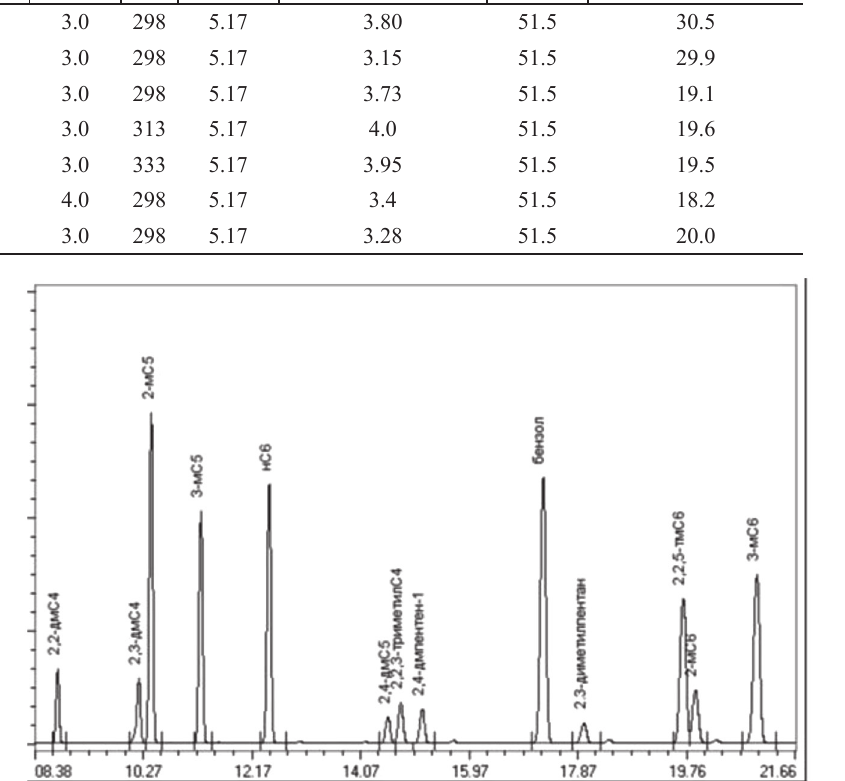
Table 3 – Hydrogenation of “stable catalysate” on the bimetallic catalysts in hexane Catalyst